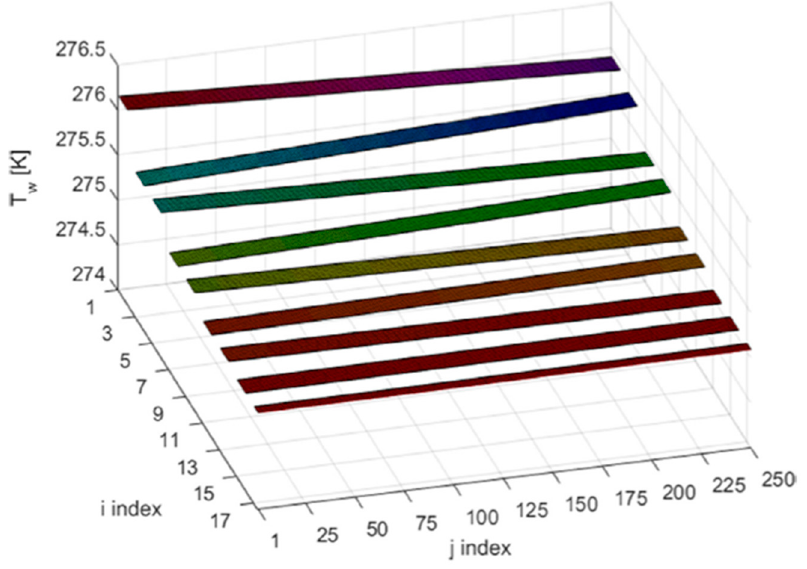
Figure 16. Wall temperature distribution in the HX first row [87].